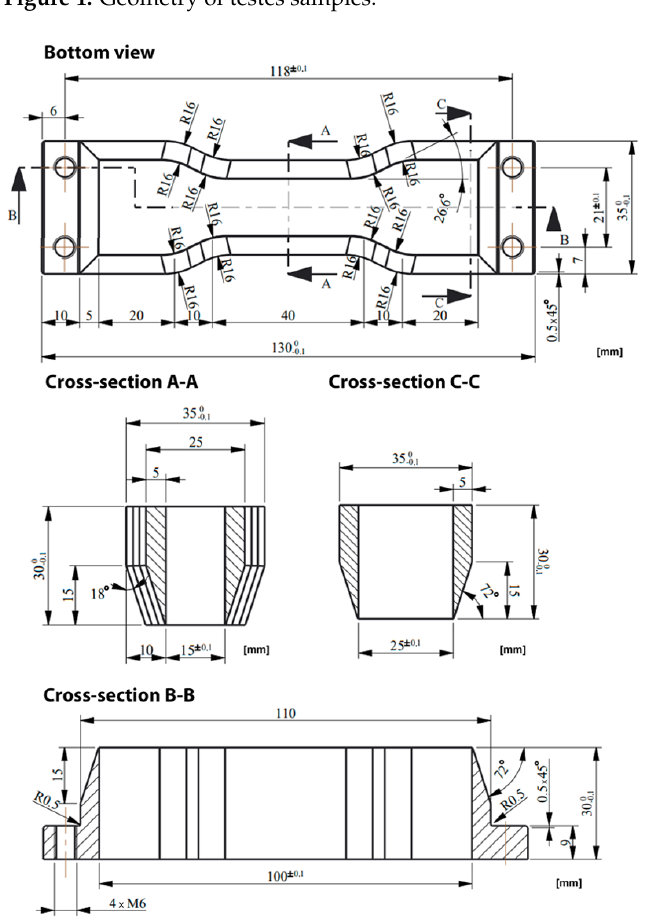
Figure 2. Cutting knife